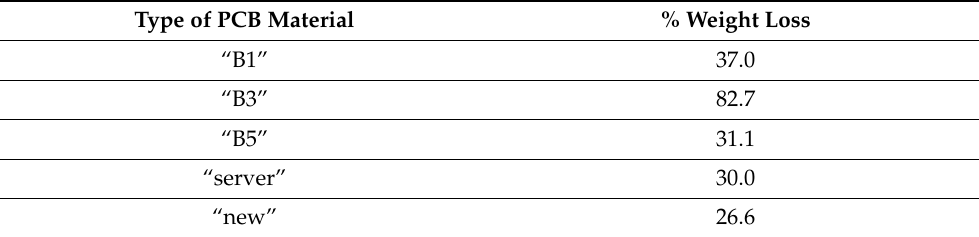
Table 2. Weight loss ( ∆ m , %) resulting of pyrolysis of initial